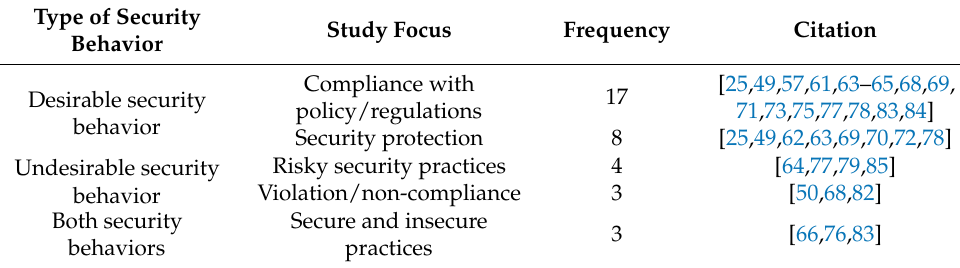
Table 7. Security behaviors investigated in the selected studies.